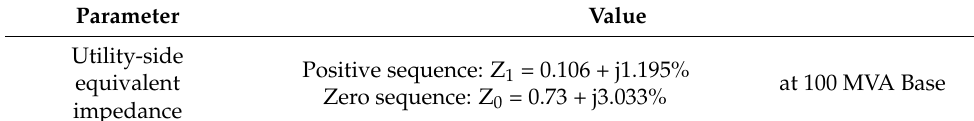
Figure 15. Part of the electric railway system in Jeolla province in South Korea. Table 6. Specifications of a railway power supply system in Jeolla province in South Korea used in the case